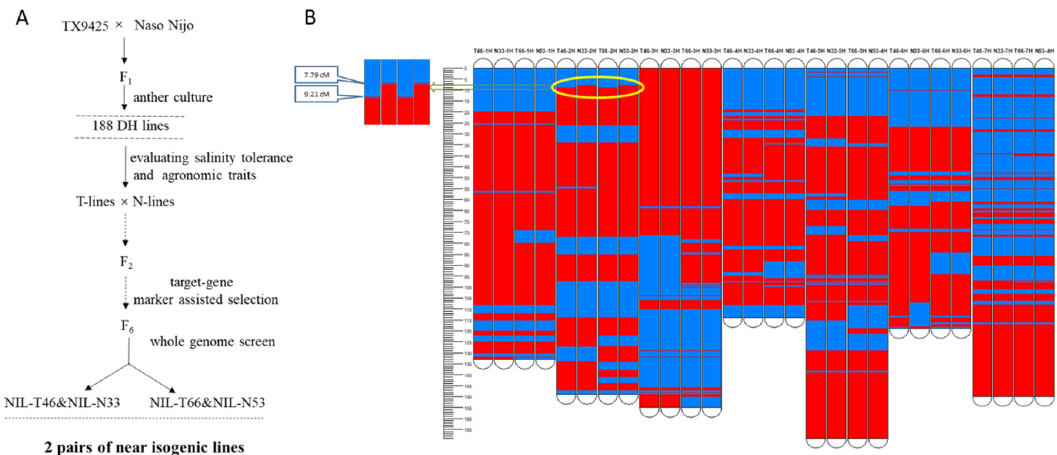
Figure 1. Construction of two pairs of NILs. A : Strategy for developing NILs. B : Comparison between genotypes of near isogenic (Pair 1: T46/N33; Pair2: T66/N53). Red: Naso Nijo backgrounds; blue: TX9425 backgrounds. Yellow circle: the major difference on 2H at the position of 6.6 ‐ 9.4 cM for two pair of NILs.